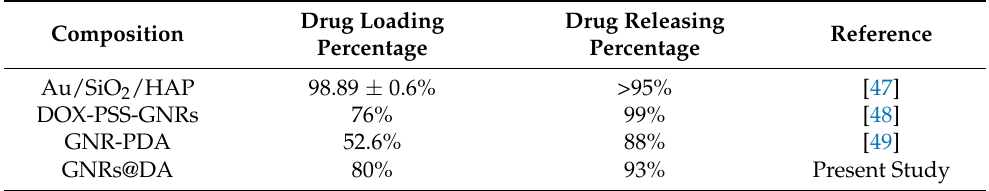
Table 2. Comparison of drug loading and releasing for different compositions of AuNRs.